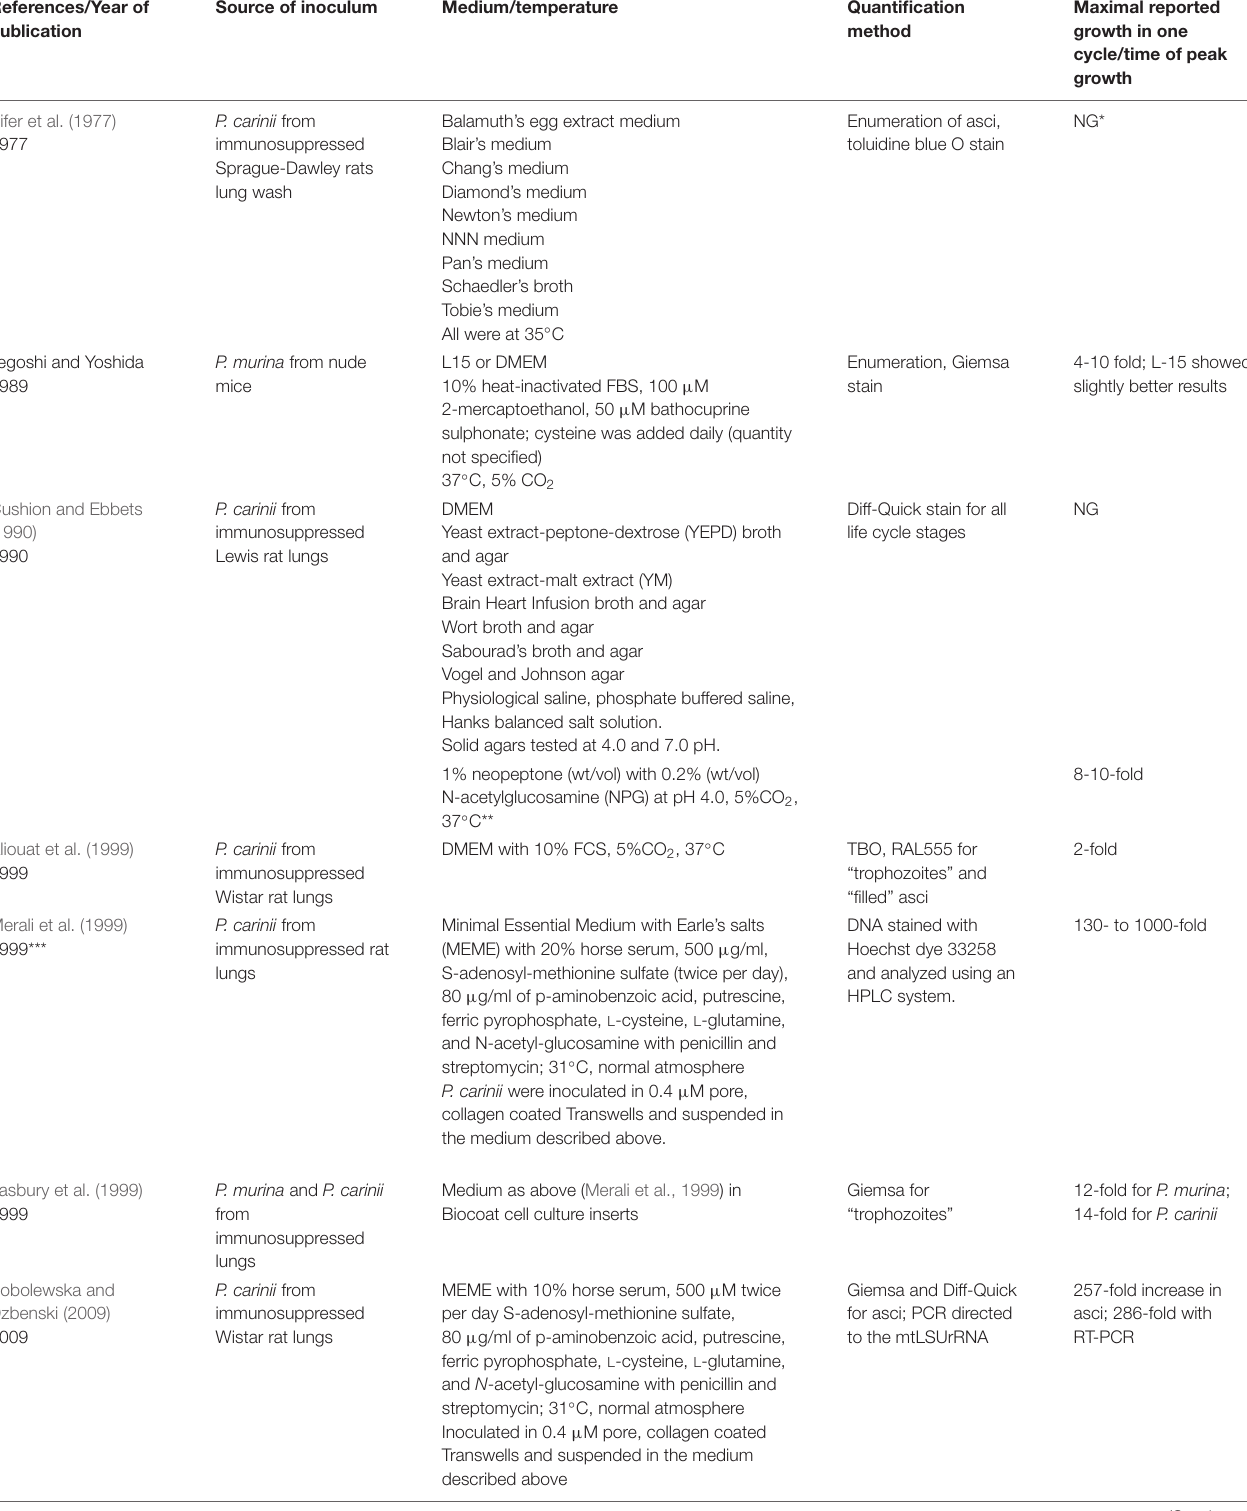
TABLE 2 | In vitro culture of Pneumocystis species in cell free